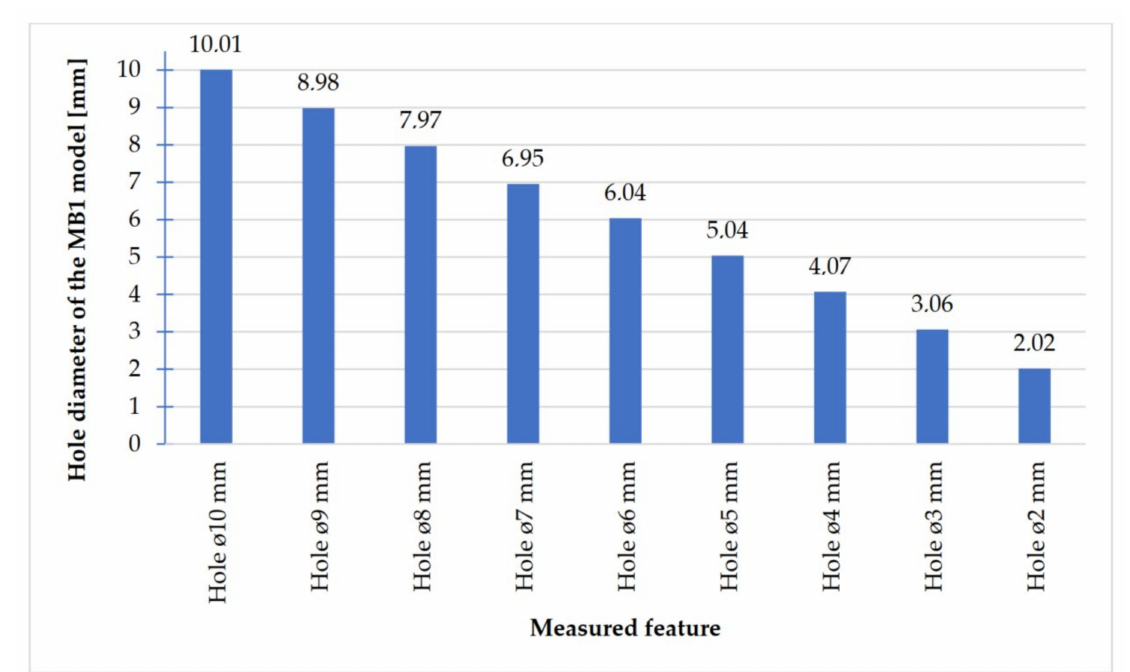
Figure 18. Average values calculated based on the cylindrical holes measurement results with dimensions Ø10–Ø0.2 mm.